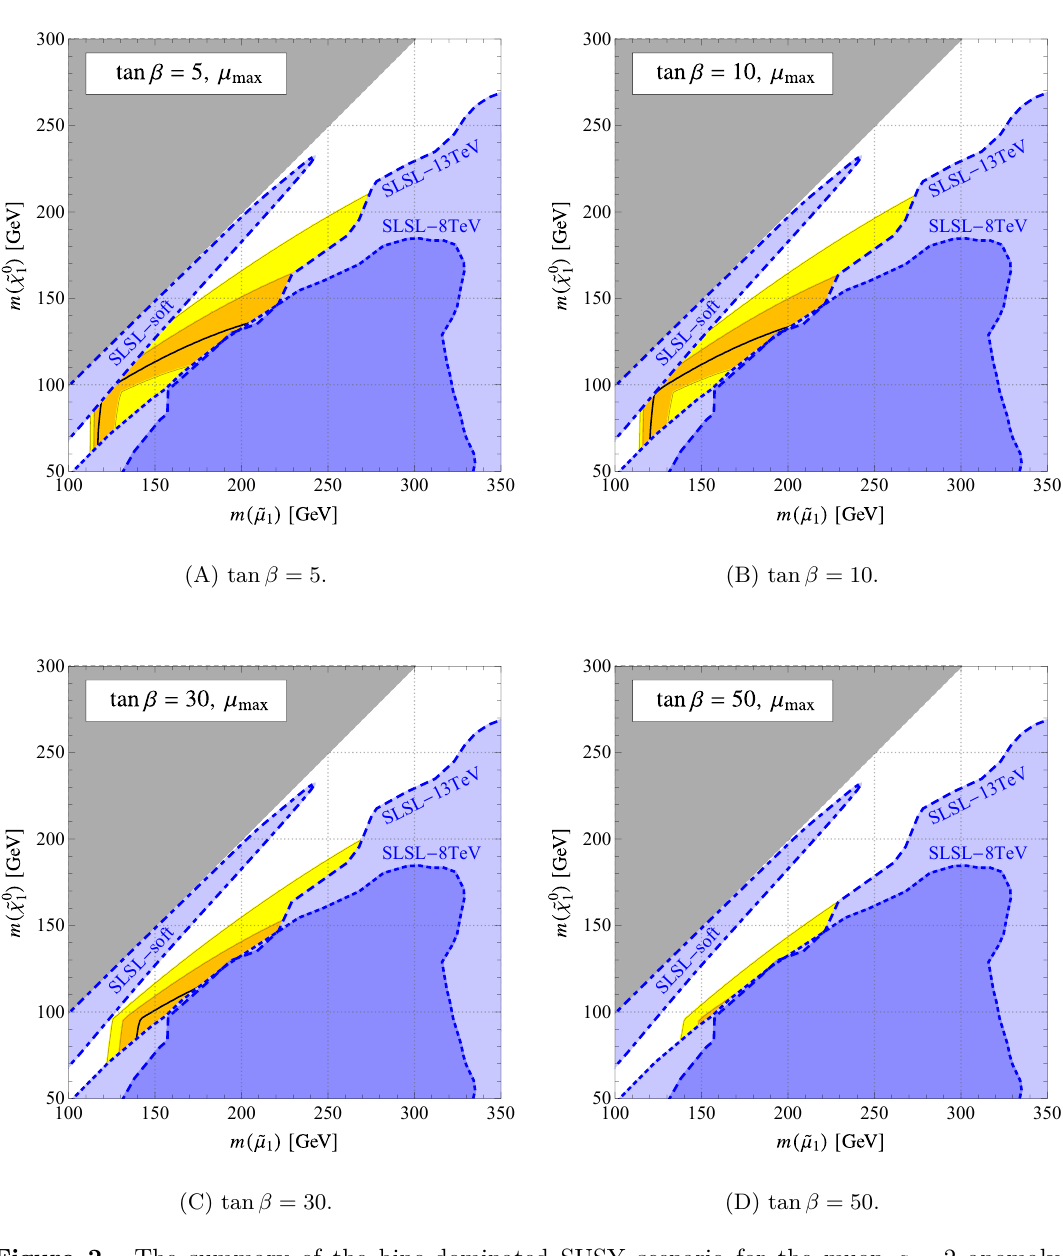
= m is assumed. Four planes respectively correspond to L R ) at each point under the conditions max exceeds the central value of µ . µ 1 is lighter than χ 0 e e 1